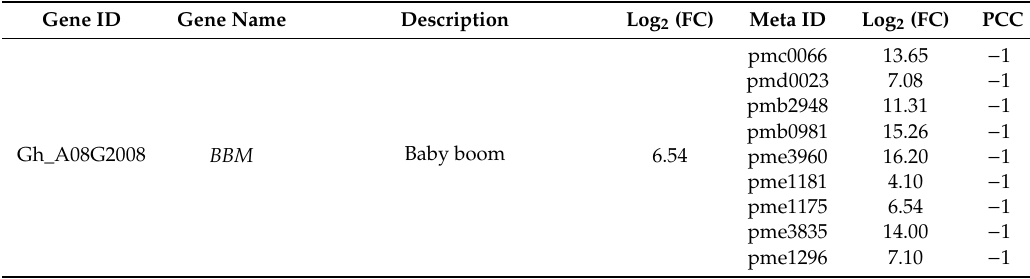
Classic gene-metabolite pairs involved in purine metabolism during embryogenic di ff erentiation (PEC vs.